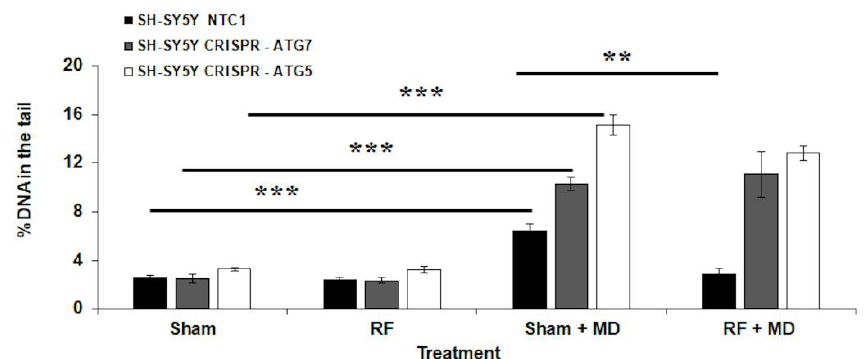
Figure 3. % DNA in the tail in SH-SY5Y CRISPR (NTC1, ATG7, and ATG5) cells exposed to RF for 20 h at 0.3 W/kg SAR. For each cell line, the following samples were analyzed: sham-exposed (Sham), RF-exposed at 0.3 W/kg (RF), sham-exposed and treated with MD (Sham + MD), RF-ex- posed and treated with MD (RF + MD). Each data point represents the mean ± SE of four (NTC1 and CRISPR-ATG7) or three (CRISPR-ATG5) independent experiments. ** p < 0.01; *** p < 0.001 (two-tailed unpaired Student’s t -test).